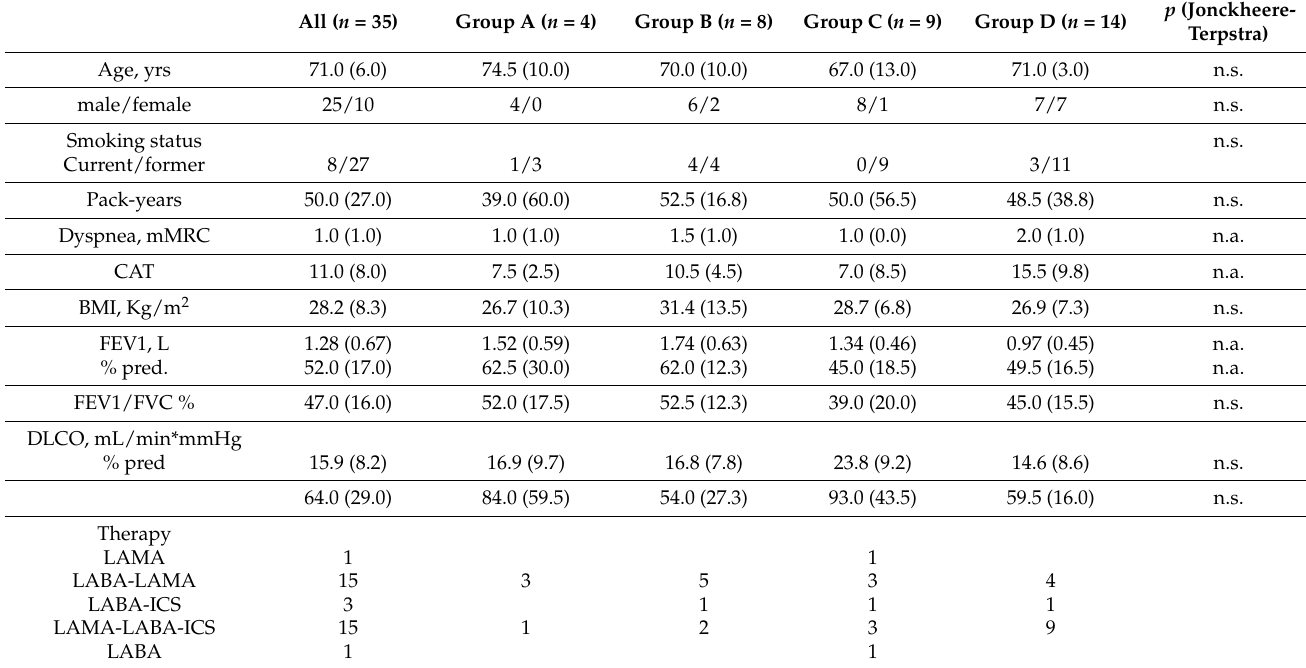
Table 1. Anthropometric and functional characteristics of patients as a whole and divided according to the 2011 GOLD document (median (interquartile range)).